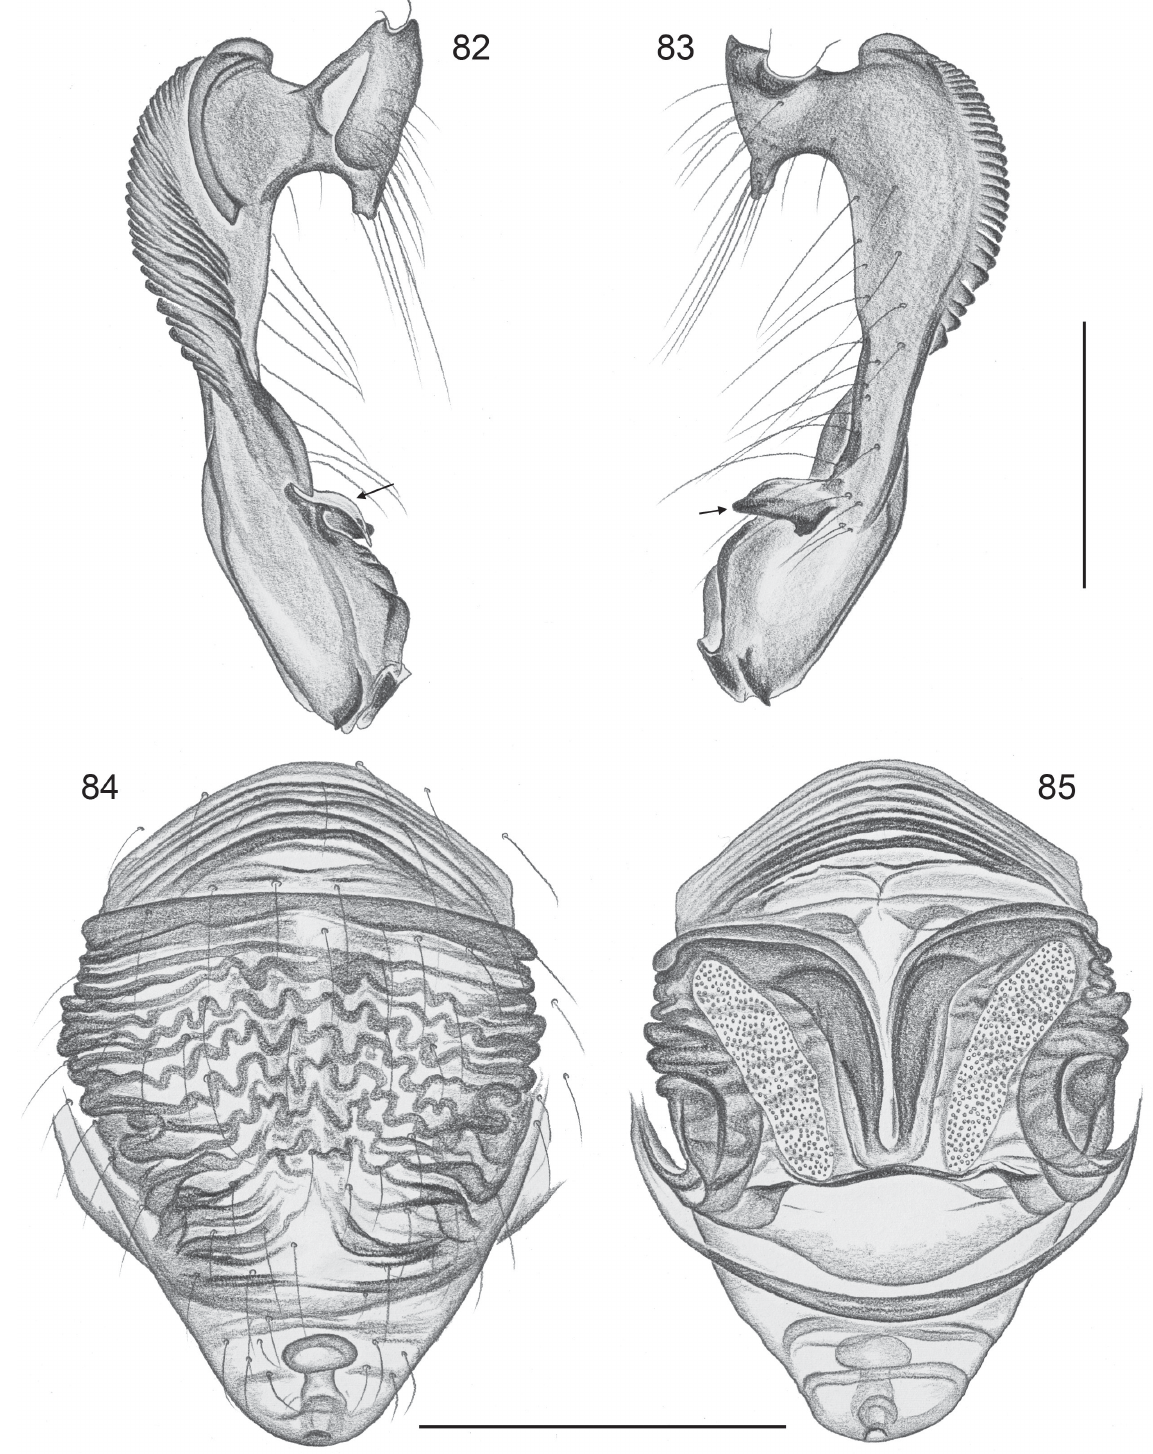
Figs 82–85. Panjange seowi Huber, sp. nov. (ZFMK Ar 14590–91). 82–83 . Left procursus, prolateral and retrolateral views (arrows point at distinctive processes). 84–85 . Cleared female genitalia, ventral and dorsal views. Scale lines: 0.5